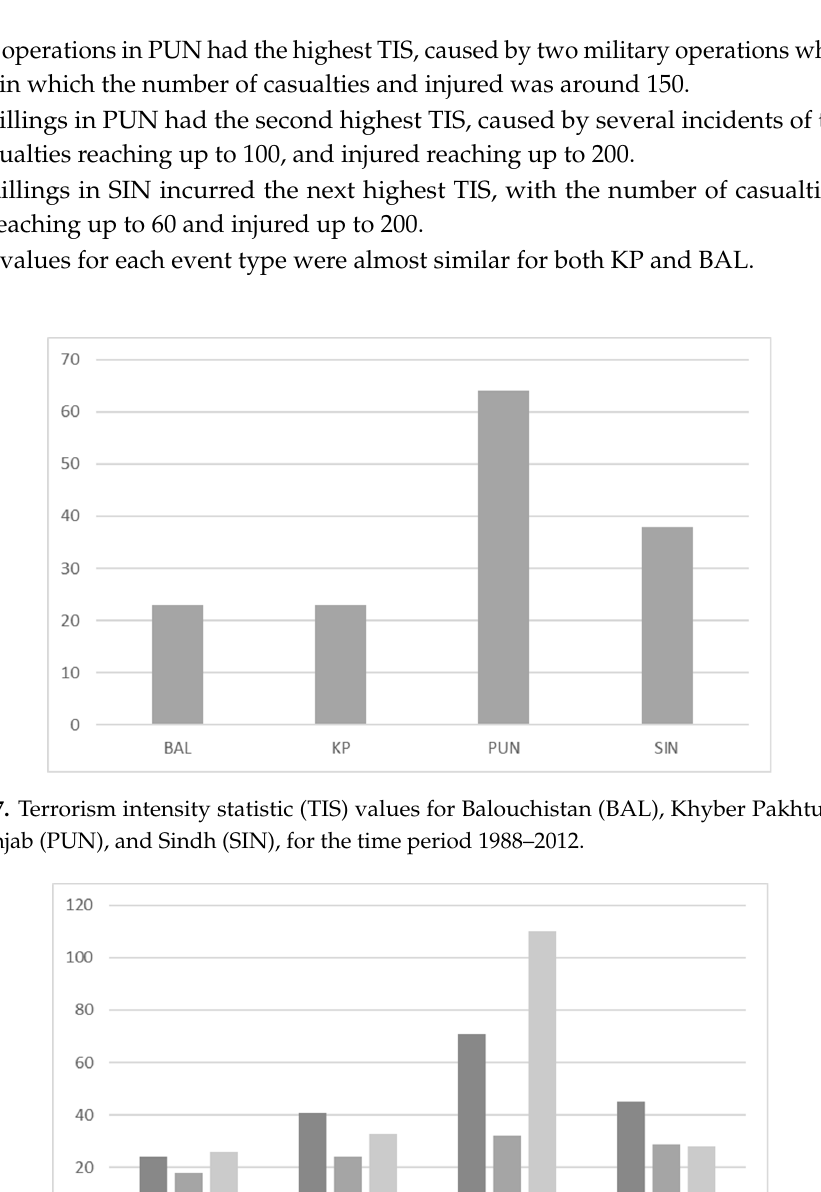
Figure 19. Area chart for annual TIS values for the time period 2001–2012.